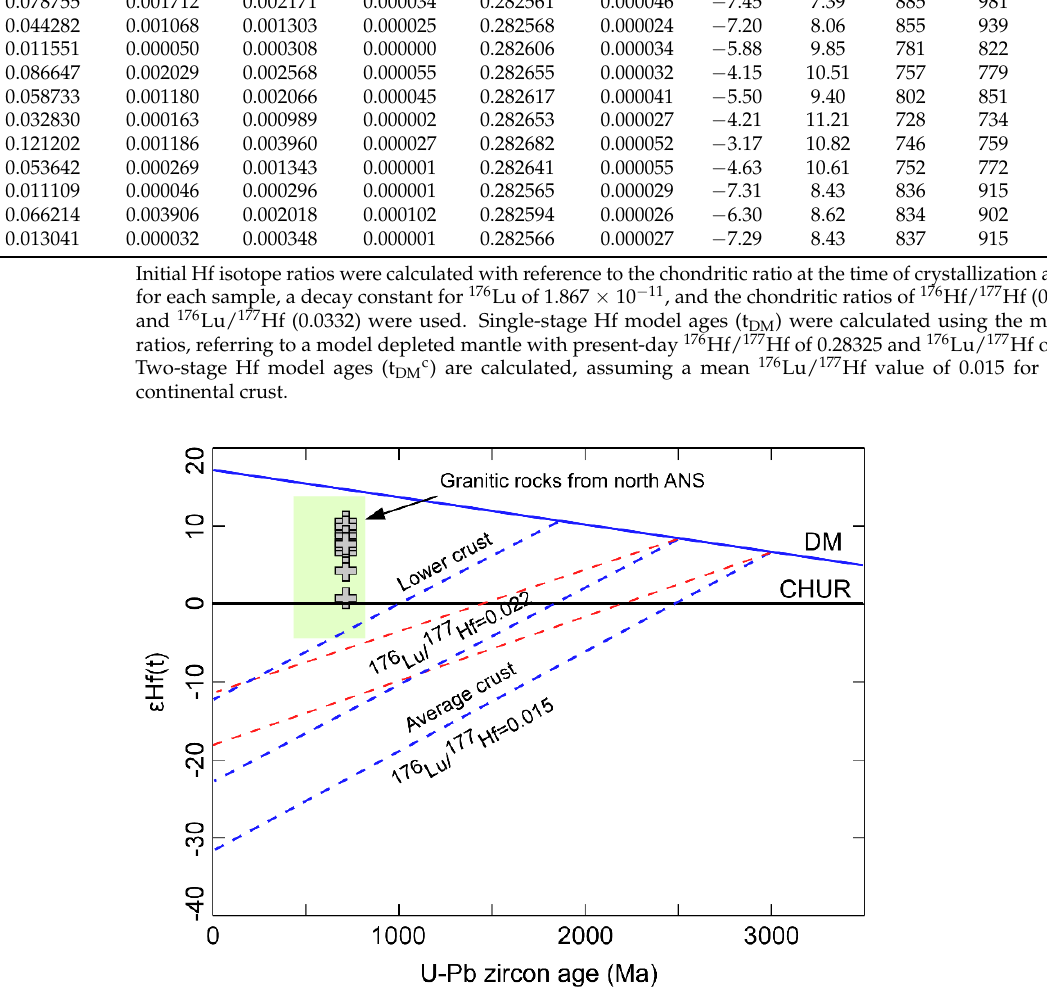
Figure 7. Epsilon Hf(t) versus age diagram showing zircon data for the Haweit granodiorite. The depleted mantle (DM) growth curve (solid line) was extrapolated from average modern-day values of 176 Hf/ 177 Hf = 0.28325 and 176 Lu/ 177 Hf = 0.0334. CHUR is the chondritic uniform reservoir. The field of granitoids from north ANS is adopted from Ali et al. [50]. Table 3. Single zircon Lu–Hf isotopic data for Haweit granodiorites from NE Sudan.